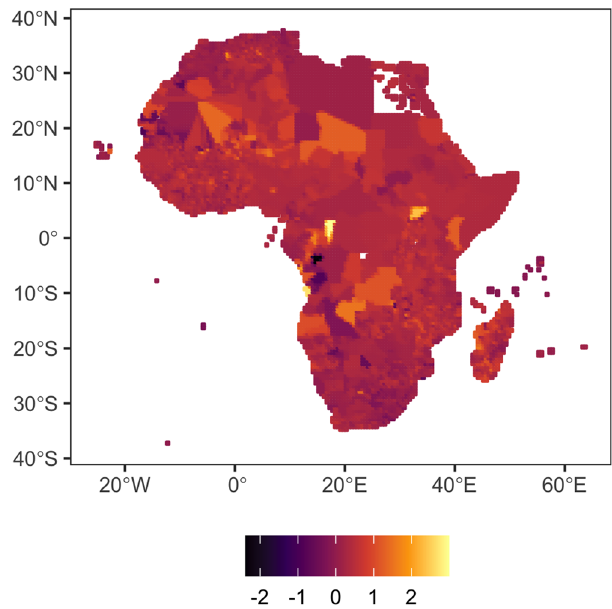
Fig. 2 | Population growth at the grid-cell level in Africa, 2005 – 2015 (log dif- ferencesoverthefullperiod).